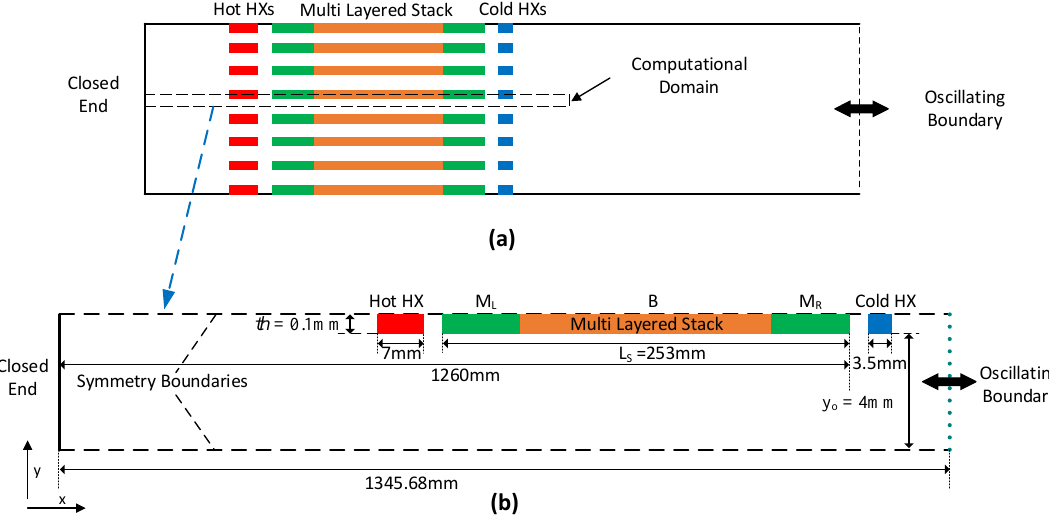
Figure 1. Geometric details of SWTAR ( a ) Schematic model ( b ) Computational domain.